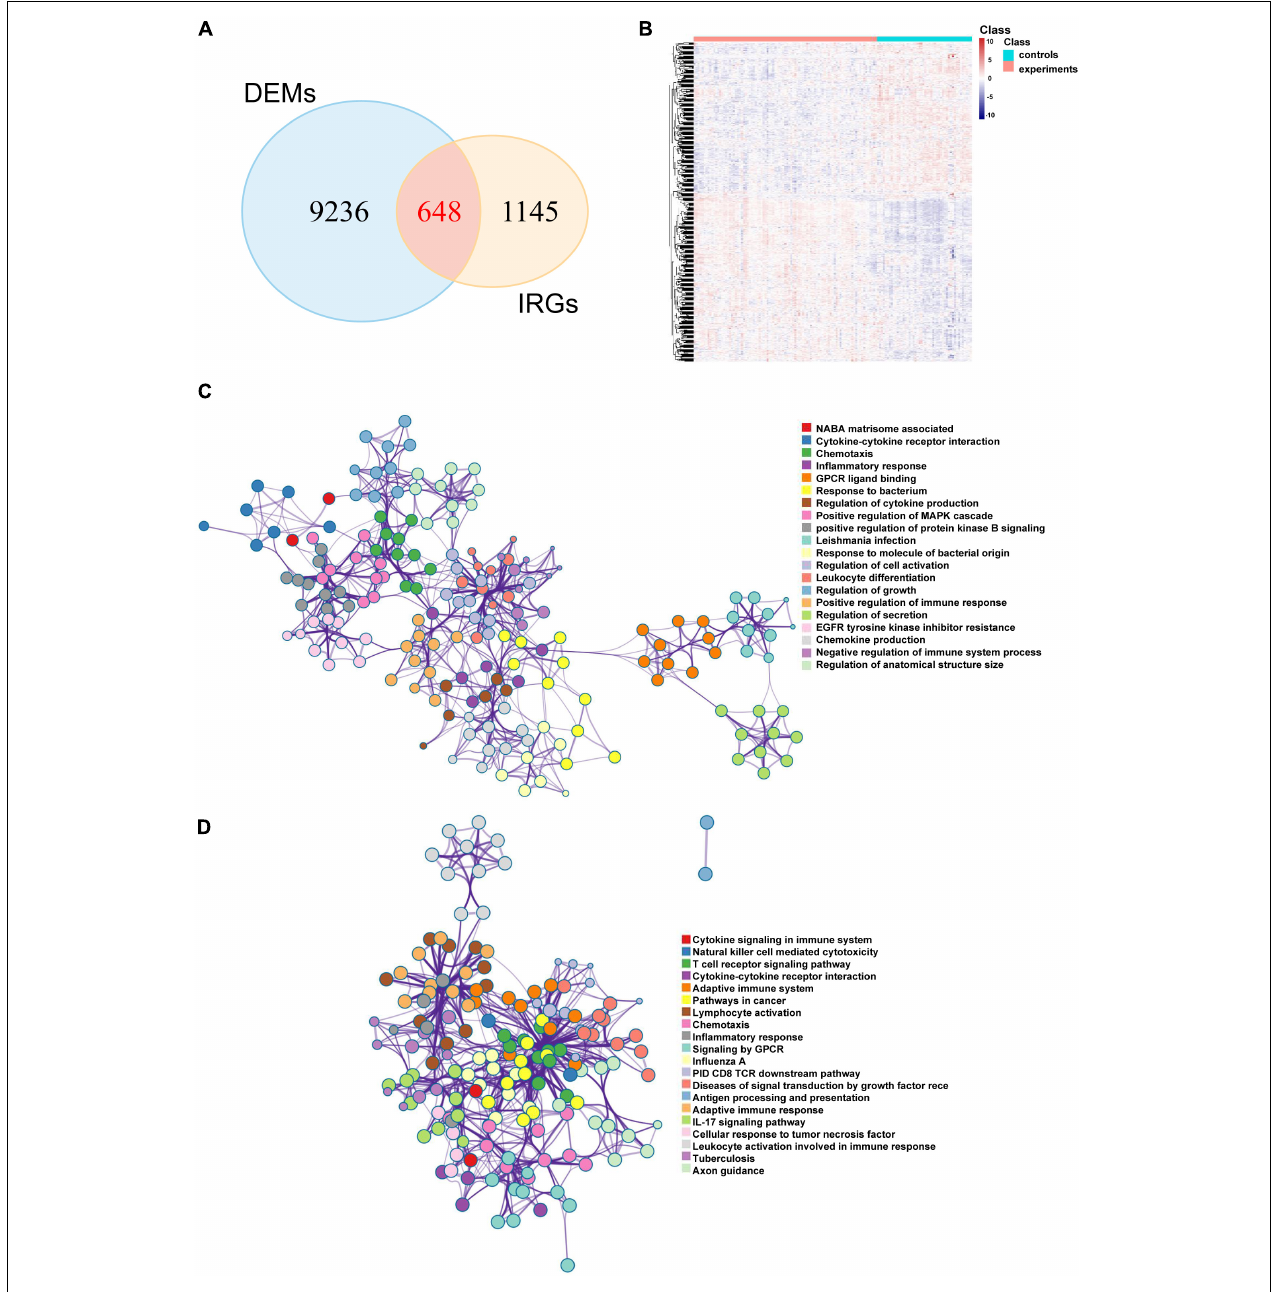
FIGURE 3 | Potential biological pathways of DEIRGs in CAD. (A) Venn diagram of the intersections between the DEMs and IRGs and the heatmap of DEIRGs. (B) The network of enriched terms of upregulated DEIRGs (C) and downregulated DEIRGs (D) via the Metascape online website; nodes of the same color belong to the same term. DEIRGs: differentially expressed immune-related genes; CAD, coronary artery disease; DEMs, differentially expressed mRNAs; IRGs, immune-related